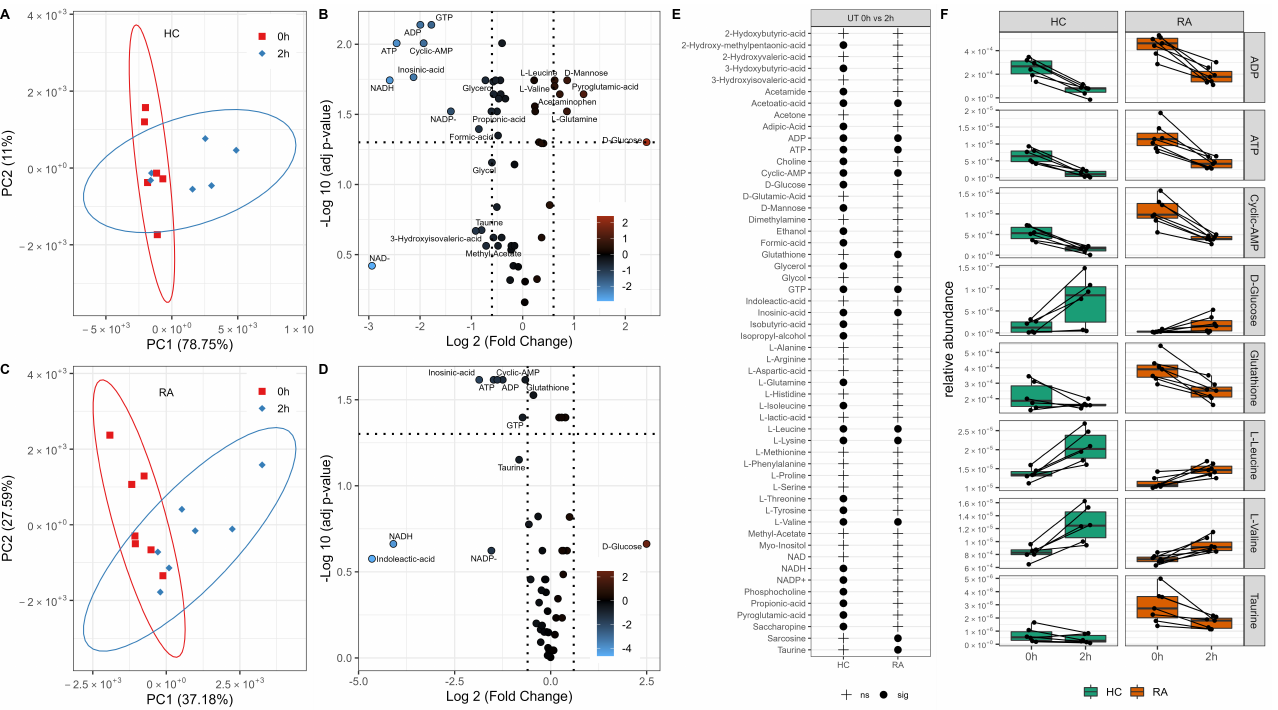
Figure 2. Metabolic adaptation of neutrophils after in vitro incubation. PCA of neutrophils showing the separation by incubation time in HC ( A ) and RA ( C ). Volcano plots ( B , D ) showing metabolites significantly different between 0 h and 2 h incubation (adj p -value < 0.05) and the log2 fold change (FC) for each metabolite as indicated by gradient colour scale provided; ( E ) table comparing metabolites are significantly different after in vitro incubation for HC and RA neutrophils. ( F ) Boxplots of significant metabolites as determined from the univariate analysis (adj p -value <